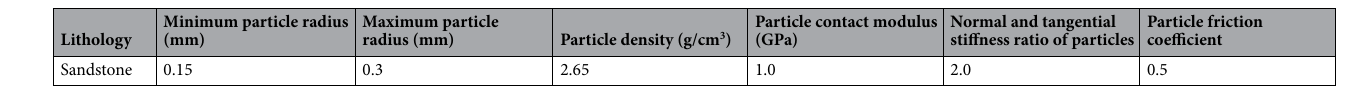
Table 1. Microscopic parameters of the test particles used in the numerical simulations.